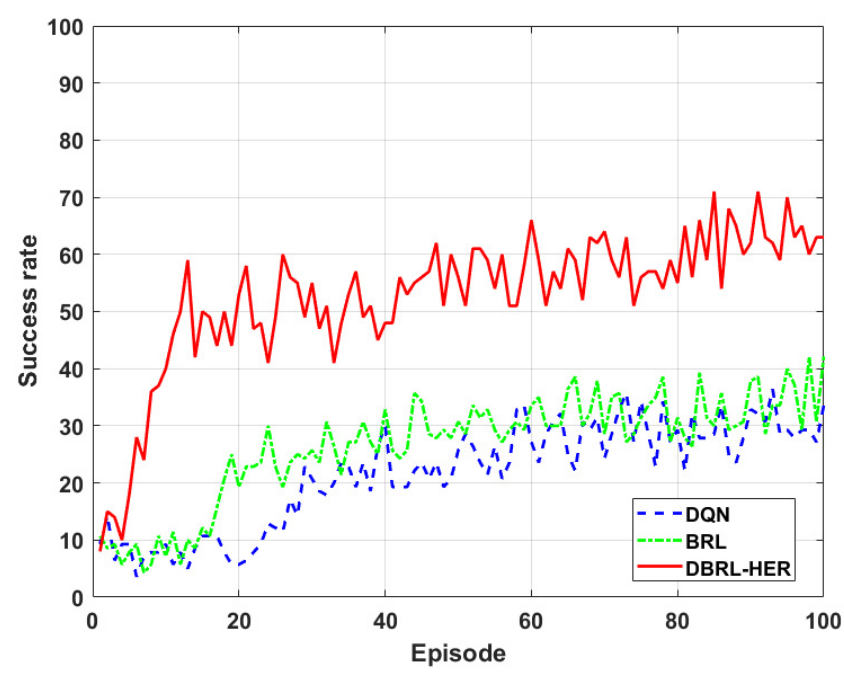
Figure 8. Collision avoidance success rate curves under 20 × 20 map.